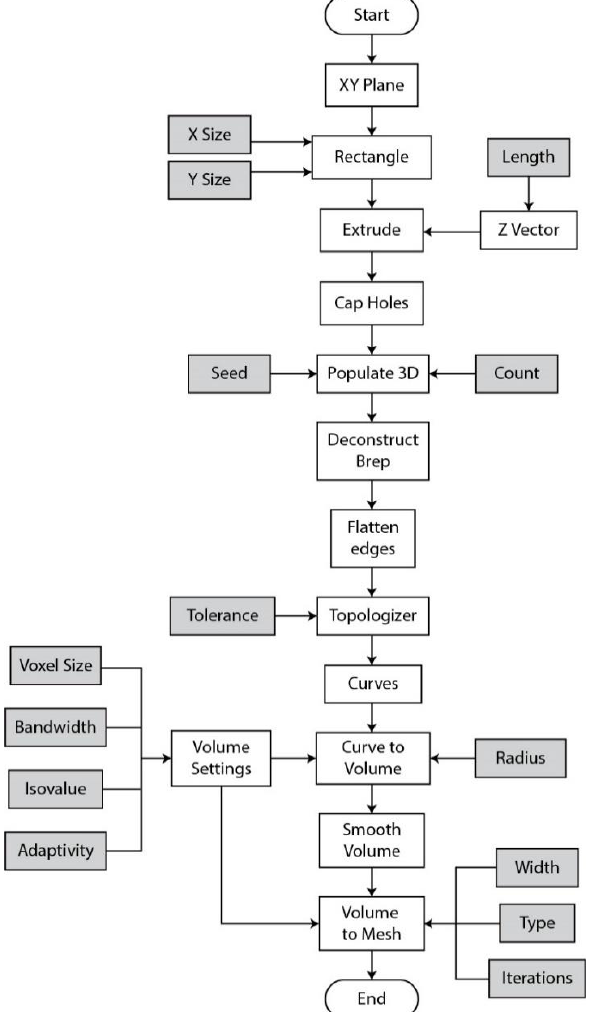
Figure 7. Second level workflow diagram of the algorithmic generation of the Voronoi lattice. Dependent components are shown in white, while independent ones (user-defined parameters) are shown in grey.